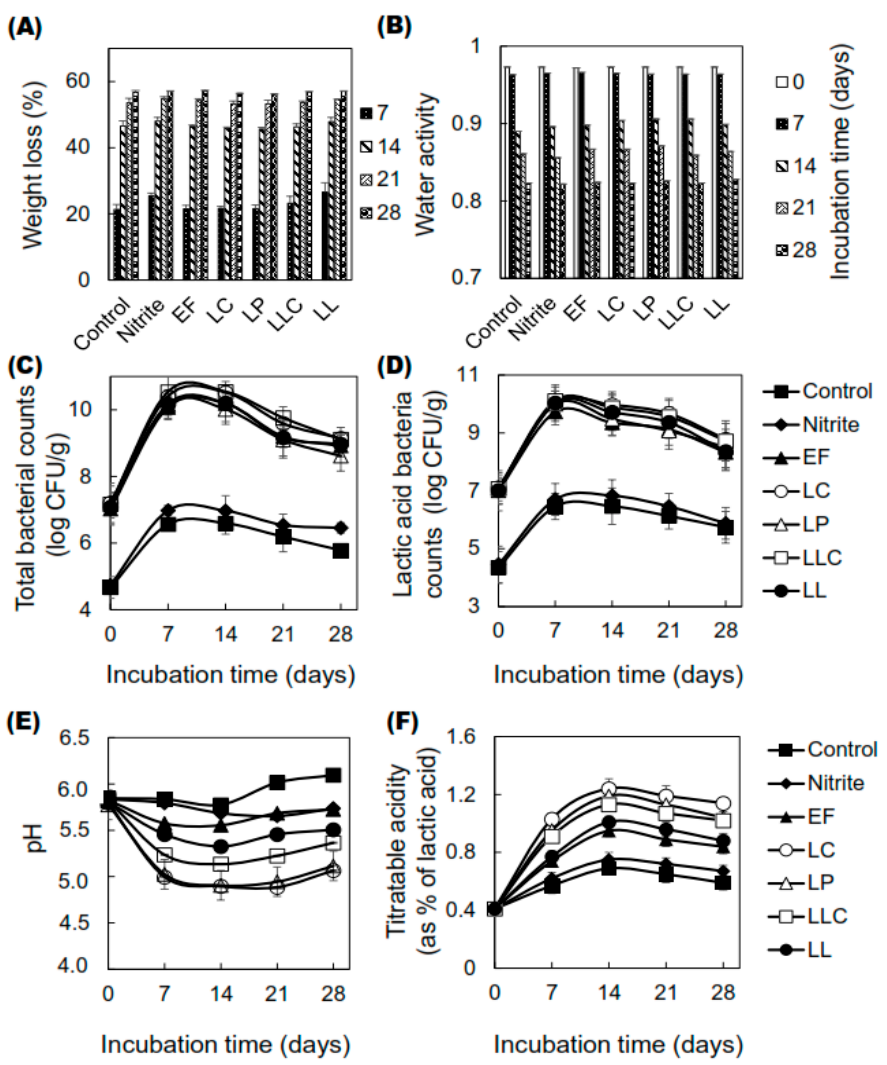
Figure 1. Changes in the technological properties of dry-cured fermented sausages during processing. Five high zinc protoporphyrin IX-(ZnPP)-forming lactic acid bacteria (LAB) as starter cultures (6 log colony forming units (CFU)/g) were used to prepare dry-cured sausages. After every 7 days of processing, the sausages were analyzed for 28 days. Changes in weight loss, ( A ) and water activity, ( B ) the evolution of total bacterial counts, ( C ) and lactic acid bacterial counts ( D ), and changes in pH ( E ) and titratable acidity as % of lactic acid ( F ) of dry-cured fermented sausages during processing are indicated. Bars represent standard errors of the mean ( n = 2). ZnPP: zinc protoporphyrin IX, LAB: lactic acid bacteria, CFU: colony forming units, EF: Enterococcus faecium , LC: Lactobacillus curvatus , LP: Lactobacillus plantarum , LLC: Lactococcus lactis subsp. cremoris , LL: Leuconostoc lactis.